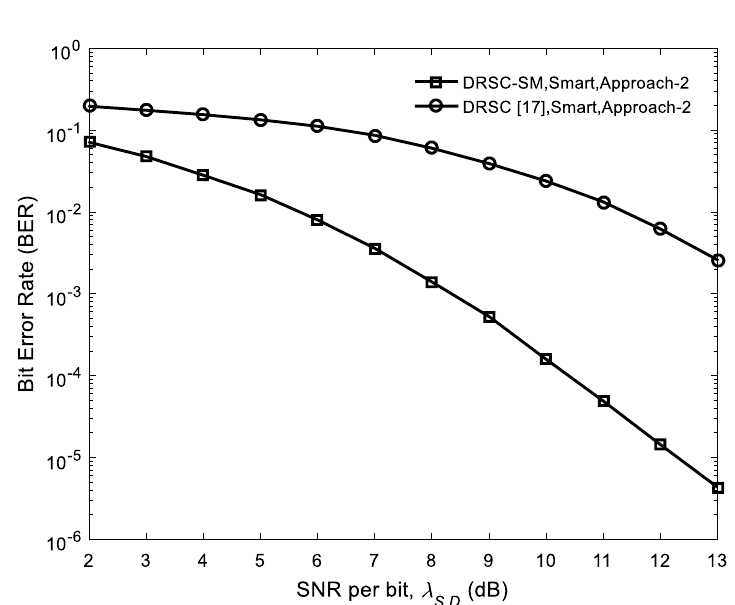
Fig. 18 BER performance of DRSC-SM ( N t = N r = 4 and 8-QAM) and DRSC (32-QAM). The solid line with square mark demonstrates the BER performance of DRSC-SM scheme. The solid line with circle mark demonstrates the BER performance of DRSC